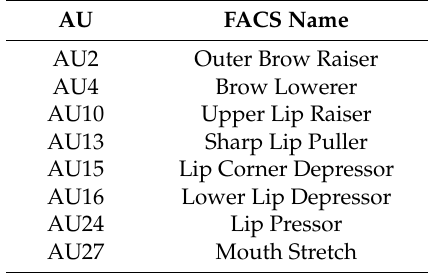
Table 1. Facial expression result of each feature and fusion feature performance with AUs.